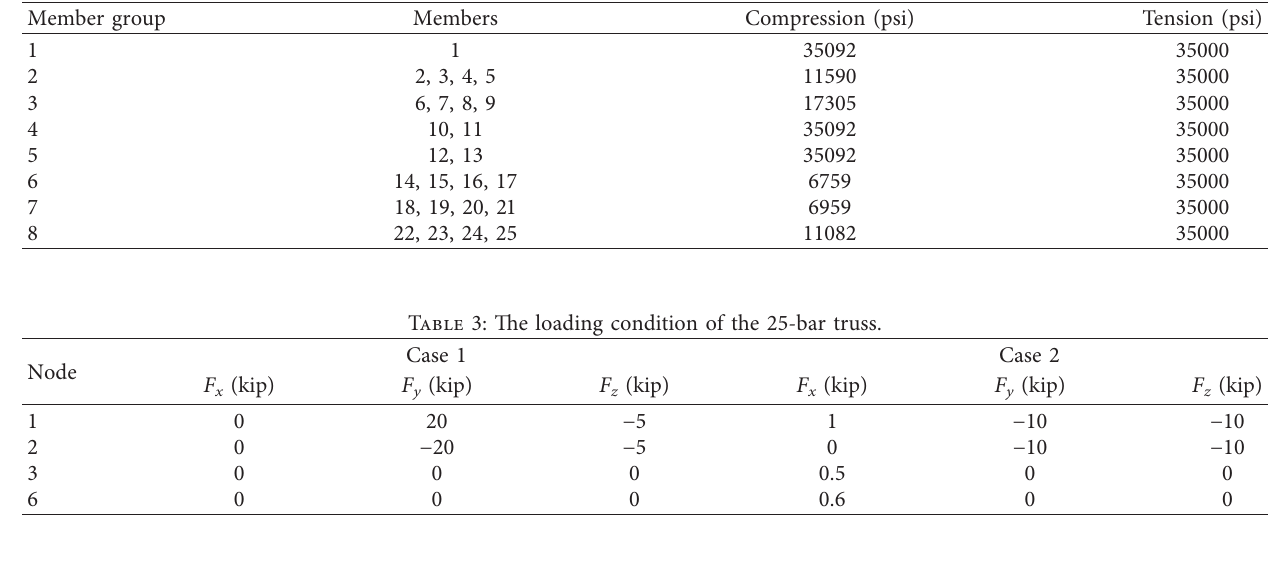
Figure 8: Configuration of the 25-bar truss (reproduced from Sonmez [10], under the Creative Commons Attribution License/public domain). Table 2: Allowable stresses for the 25-bar